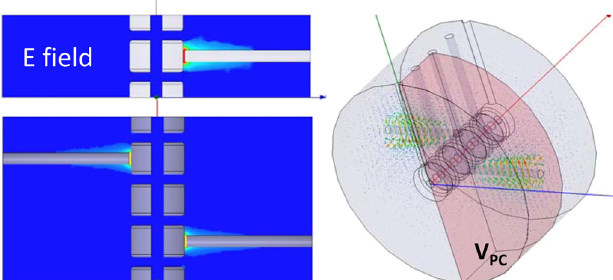
FIG. 5. On the left side, electric fields of two cavity configu- rations equivalent on number of PCs per unit length is shown. On the right side, the shadowed volume is V definition of the equivalent diameter D